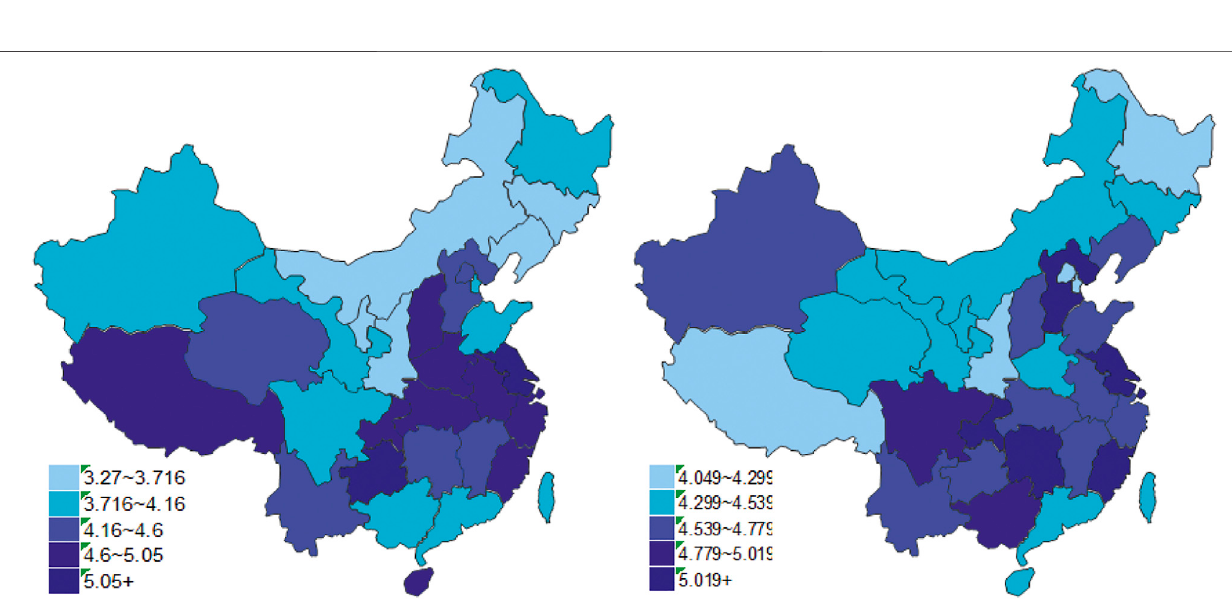
FIGURE 6 | The comparison of the average network path between 2011 and